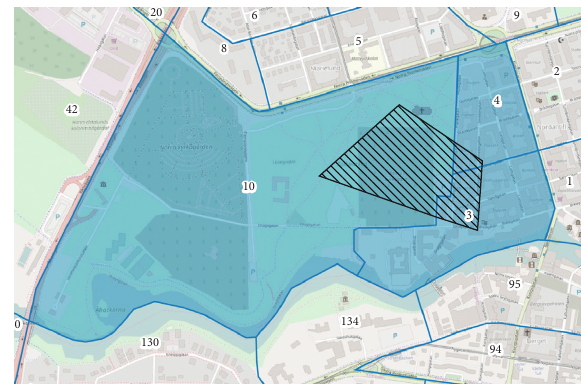
Figure 4: Example of the conversion to traffic analysis zones (TAZs). The travel demand connected to the black-shaded Voronoi cell is distributed among the blue traffic analysis zones (TAZs) which overlap with the Voronoi